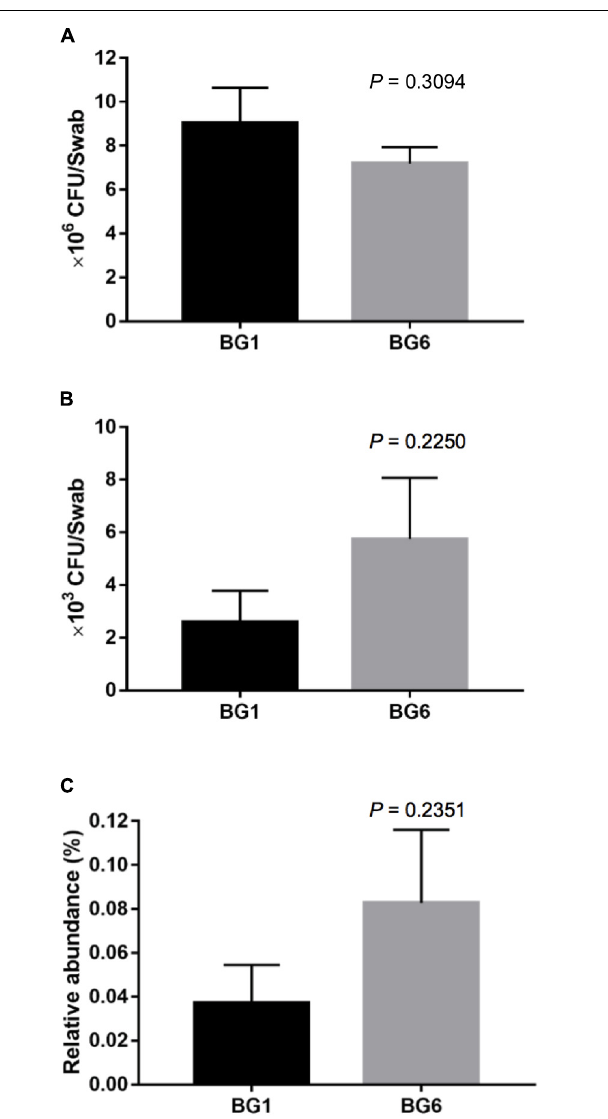
FIGURE 8 | The concentration of ampicillin resistant bacteria (ARB). The concentration of total bacteria (A) . The absolute concentration of ARB (B) . The relative abundance of ARB (C)